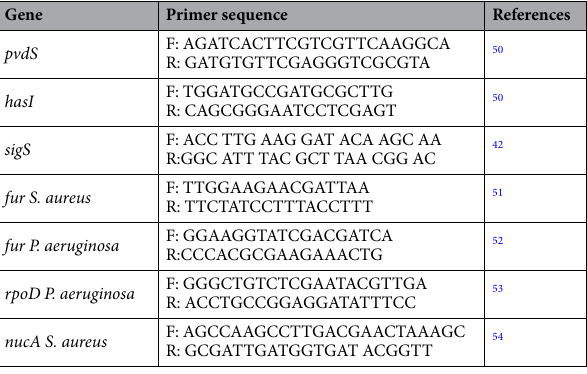
gene expression levels were calculated using the 2 −ΔΔCT method, and the data were normalized to the reference gene 49 .